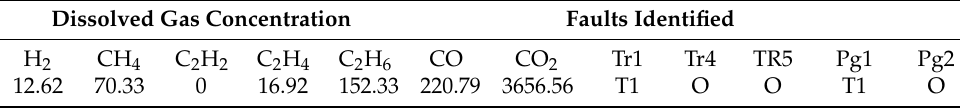
Table 16. DGA analysis and fault identification.